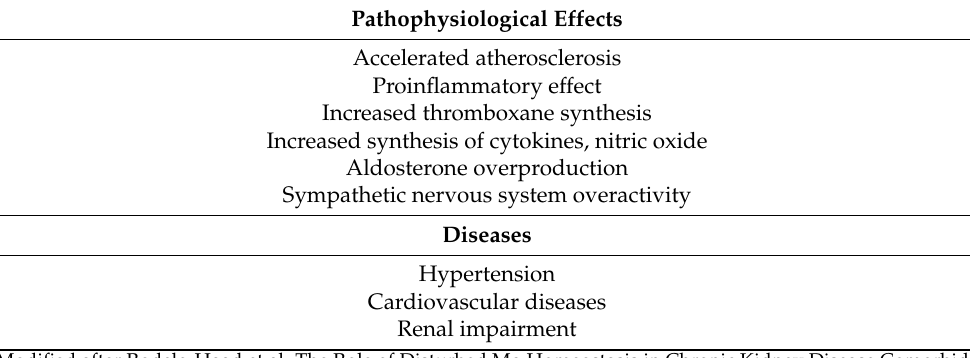
Table 2. The consequences of Mg deficiency